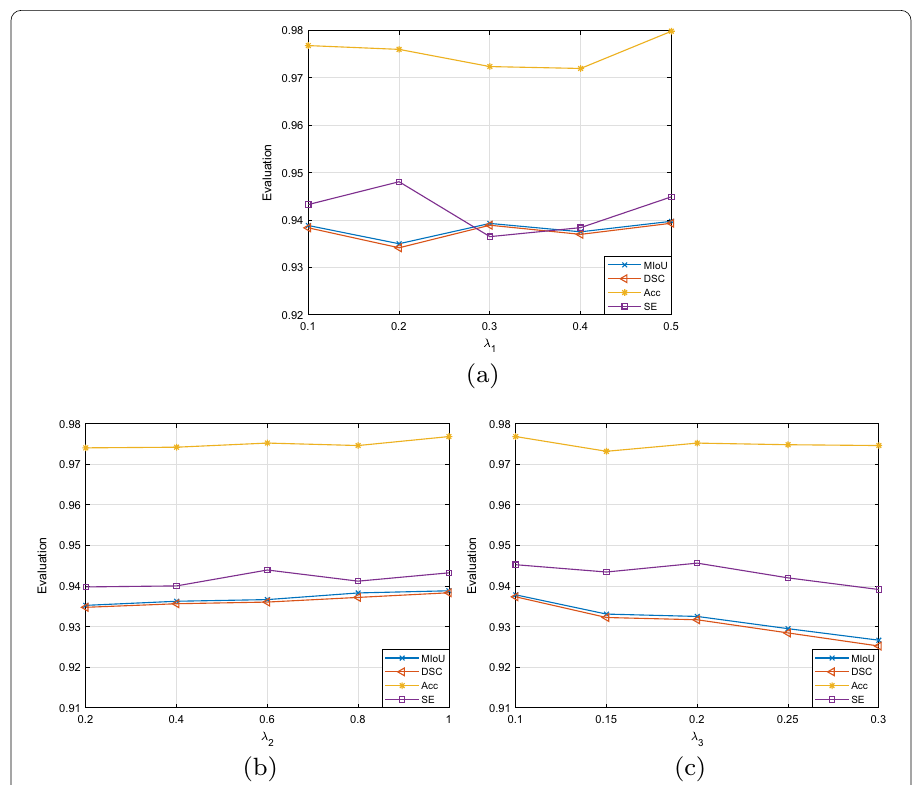
Fig. 11 Influence of the values of parameter on experimental results, a (cid:31) 2 = 1 , (cid:31) 3 = 0.1 ; b (cid:31) 1 = 0.1 , (cid:31) 3 = 0.1 ; c (cid:31) 1 = 0.1 , (cid:31) 2 =